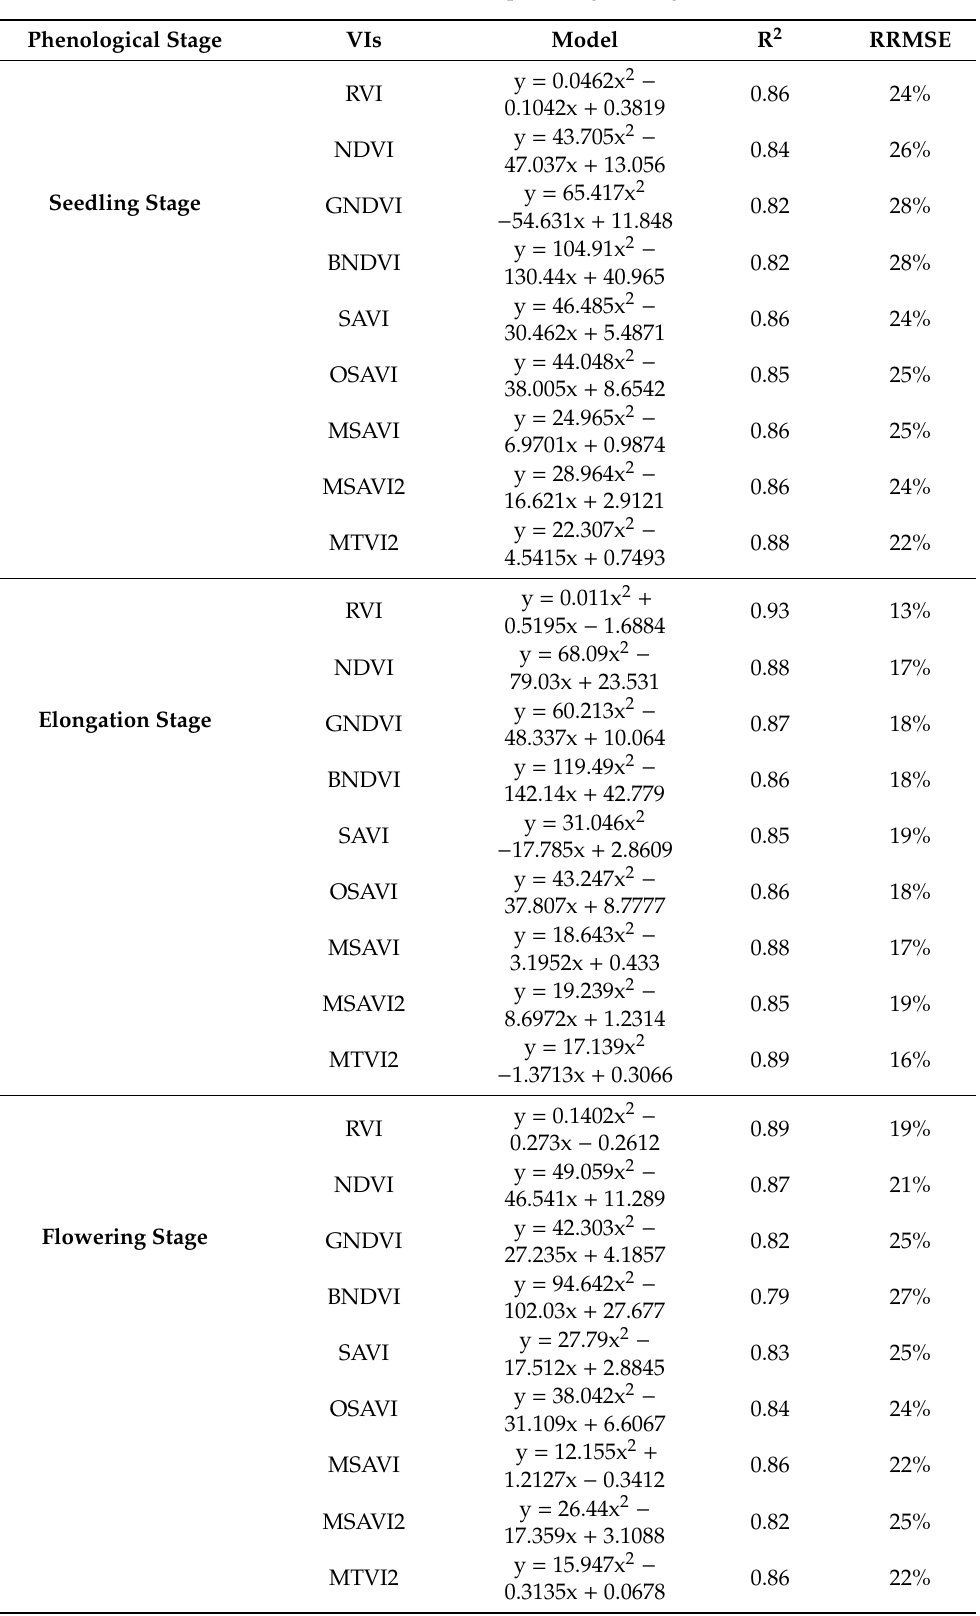
Table 4. Quadratic polynomial regression and summary statistics of relationship between LAI and studied VIs based on calibration data set at di ff erent phenological stages. Phenological